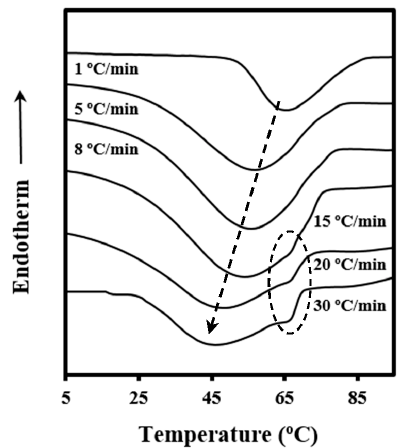
Figure 2. Exothermic DSC traces performed with PDO at the indicated cooling rates. The dashed ellipse contains the high temperature crystallization peak detected at high cooling rates, whereas the dashed arrow indicates the evolution of the main crystallization peak.